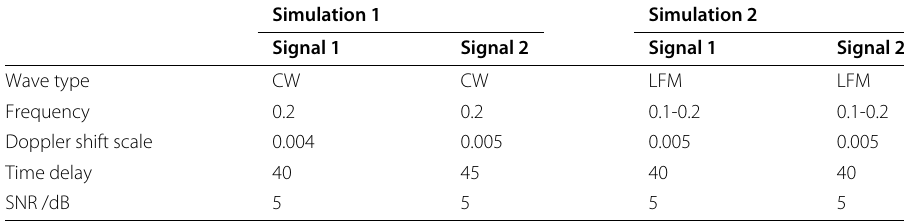
Table 2 Directions and SNR of the